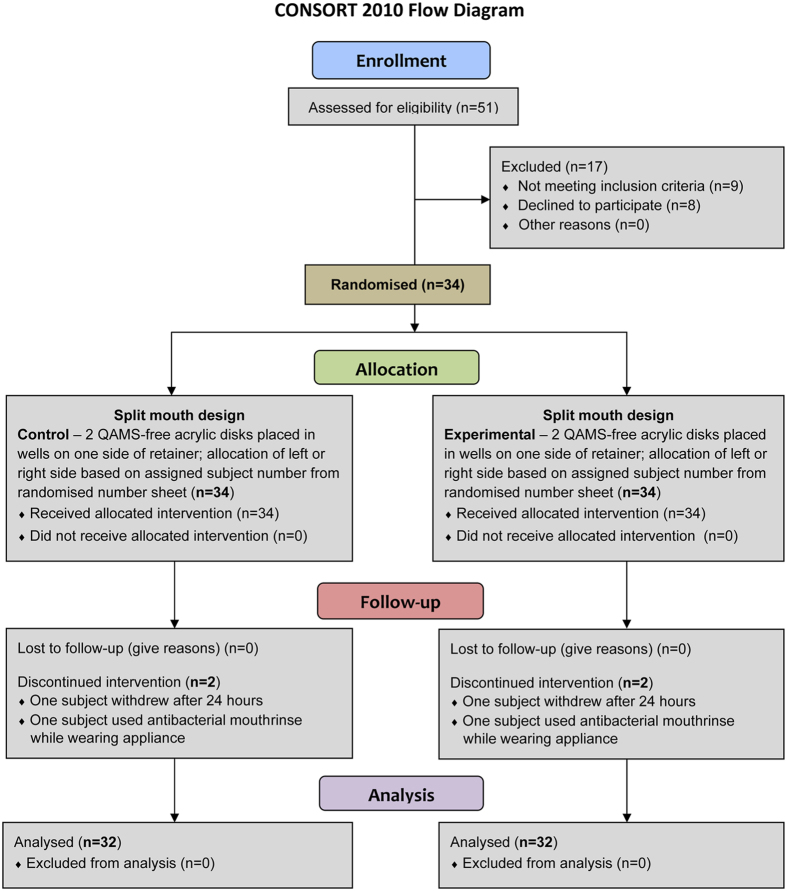
CONSORT flow diagram of subject randomisation and selection criteria.